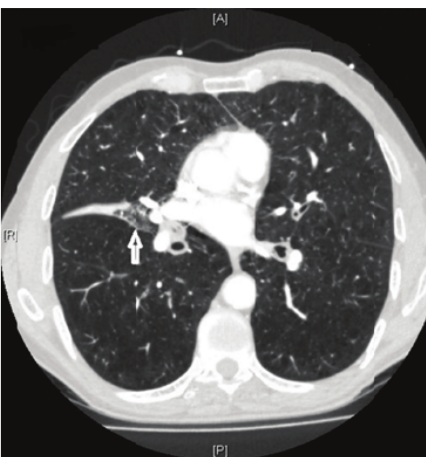
Figure1:CT-angiogramofthelungshowingsevereemphysemaand near complete collapse of right middle lobe.